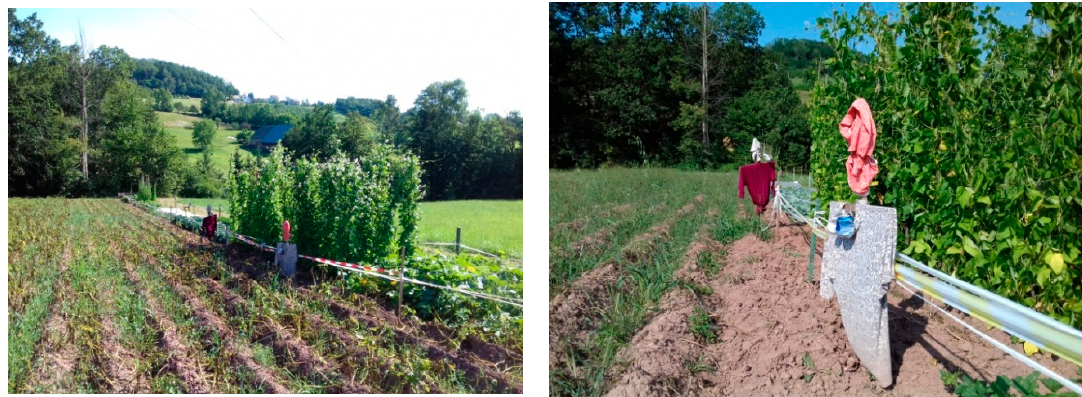
Figure 2. Scarecrows in a potato field, next to vegetables. Near Grybów (Ma ł opolskie Voivodeship). Source: author.